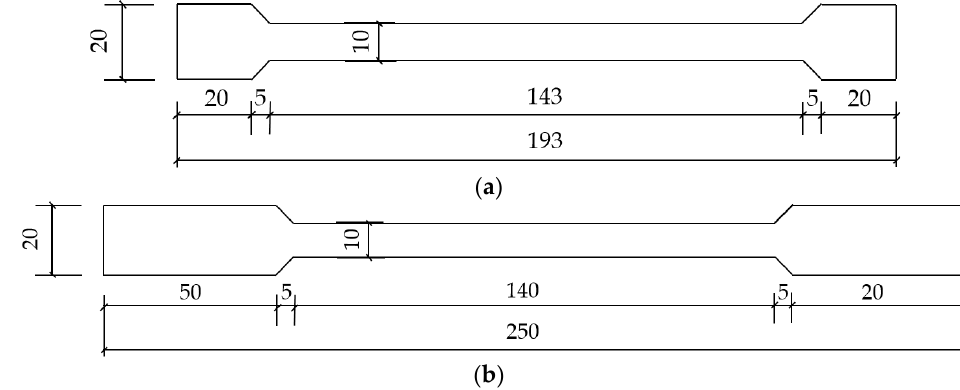
Figure 8. Coupon test specimens. ( a ) U connector, ( b ) other steel.